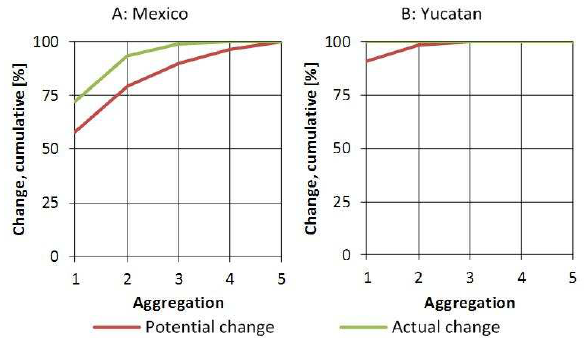
Figure 3. Proportion of change pixels detected one to five times